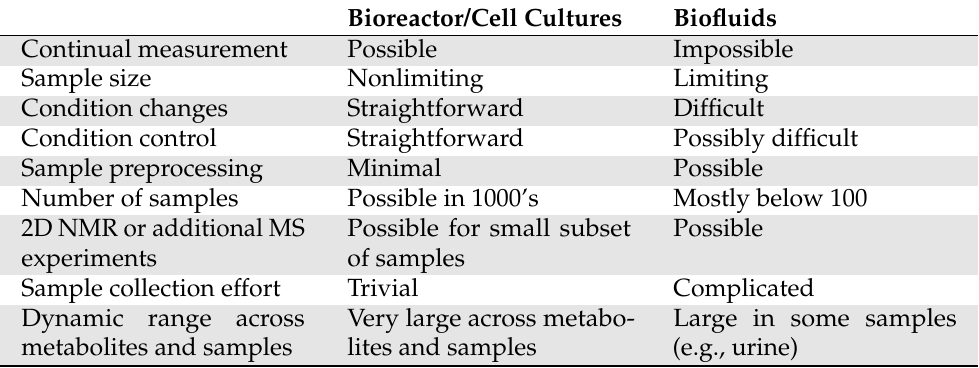
Table 1. Comparison between biofluid vs. cell culture NMR